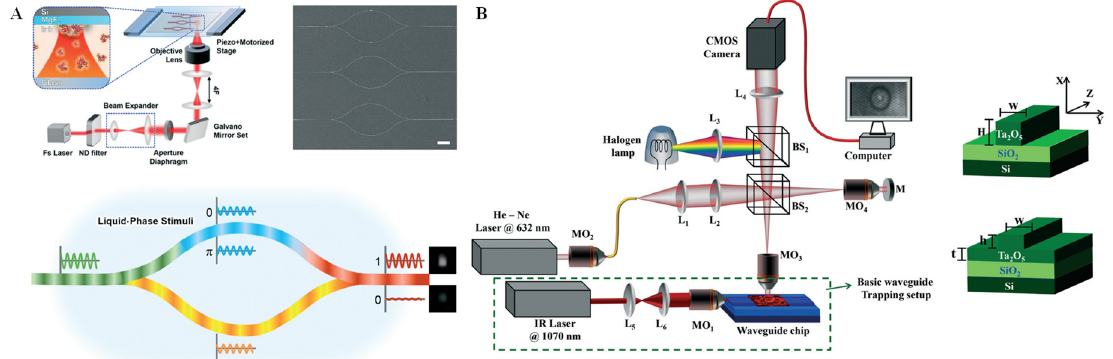
Figure 4. Interferometry technique and applications. ( A ) Beam path diagram of the M-Z interferometric and the chemical sensing process of a protein hydrogel by liquid-phase stimuli. Reprinted with permission from ref. [61], Copyright 2020, Royal Society of Chemistry. ( B ) Schematic of the phase imaging flow of single cells by a microwave interferometric system on a chip, with strip and rib optical waveguide geometries. Reprinted with permission from ref. [62], Copyright 2018, Royal Society of Chemistry.